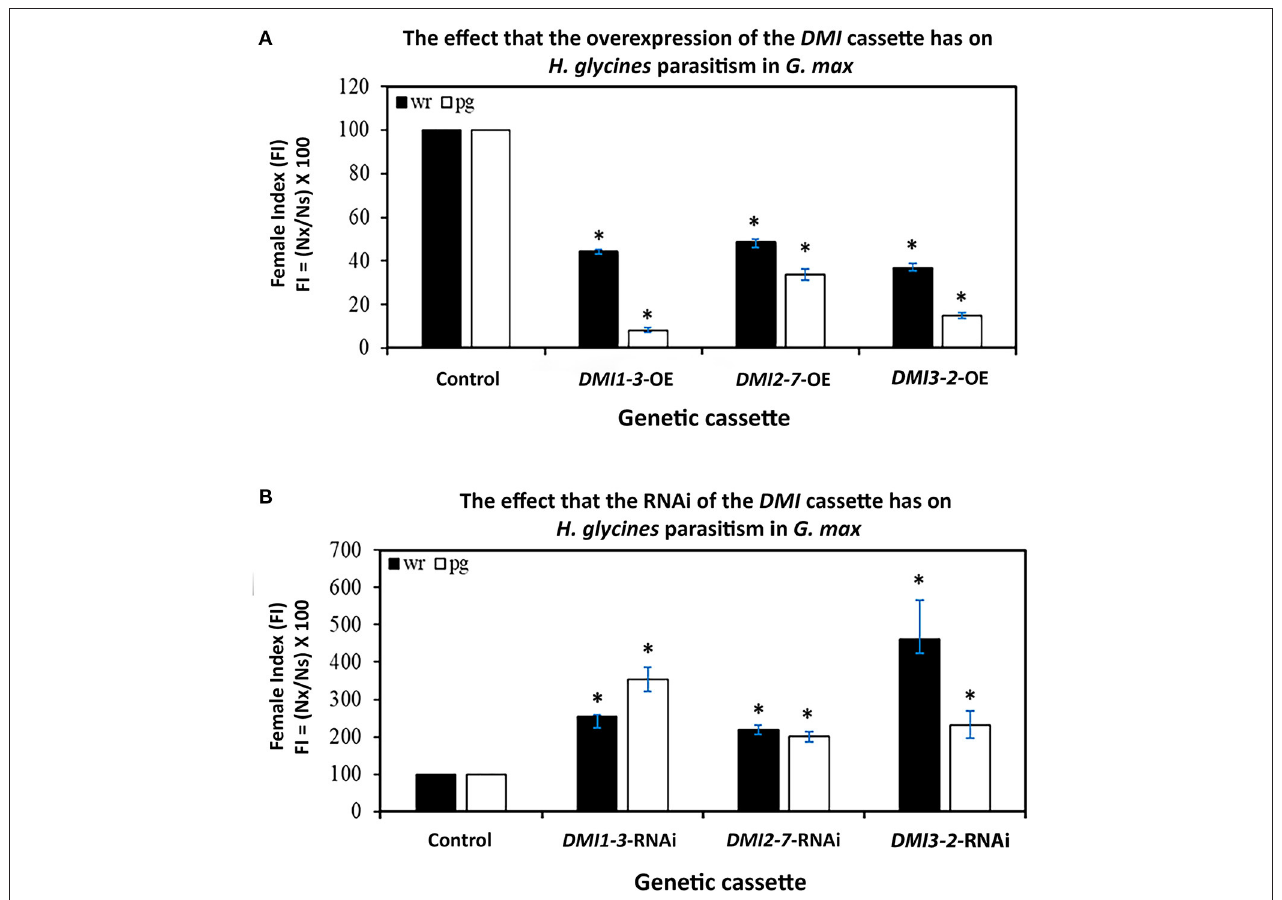
FIGURE 2 | The FI for DMI1-3 , DMI2-7 , and DMI3-2 -OE and -RNAi roots as compared to their respective pRAP15- ccd B and pRAP17- ccd B controls. The statistical significance (*) was determined by the MWW Rank-Sum Test, p < 0.05 ( Mann and Whitney, 1947). The analyzed transgenic roots for DMI1-3 -OE ( n = 30), DMI2-7 -OE ( n = 30), and DMI3-2 -OE ( n = 30) were compared to the pRAP15- ccd B control ( n = 36). The analyzed transgenic roots for DMI1-3 -RNAi ( n = 30), DMI2-7 -RNAi (n = 30), and DMI3-2 -RNAi ( n = 30) were compared to the pRAP17- ccd B control ( n = 34). Please refer to Materials and Methods subsection: The infection of G. max by H. glycines , cyst extraction and female index calculation, for